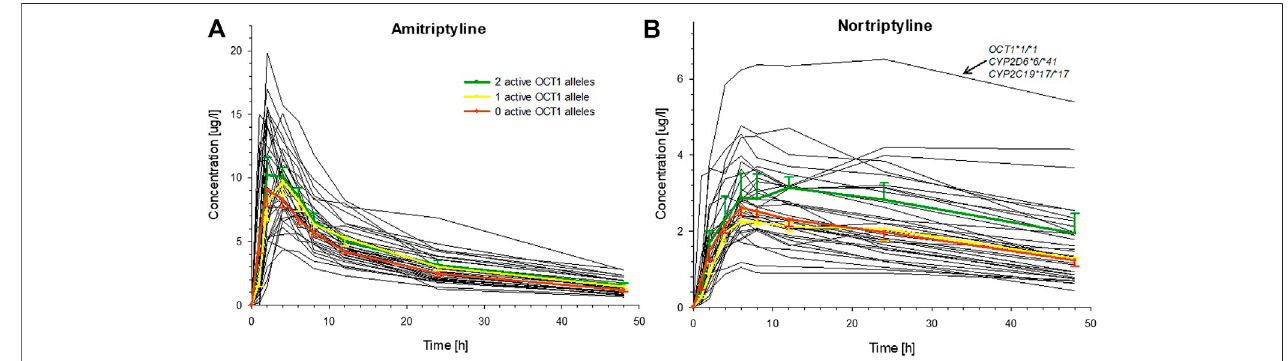
FIGURE 3 | Individual plasma concentrations of (A) AT and (B) NT over time for all healthy volunteers (black curves), indicating the large interindividual variation for these tricyclic antidepressants. The mean ( ± SEM) concentrations for carriers of two (green), one (yellow), or zero (red) active OCT1 alleles are superimposed (OCT1- dependentdifferencesinAUCwerenotstatisticallysigni fi cant).ThesingleparticipantwiththehighestNTconcentrationshadwild-typeOCT1genotype,reducedactivity CYP2D6 genotype, and a very high activity CYP2C19 genotype.